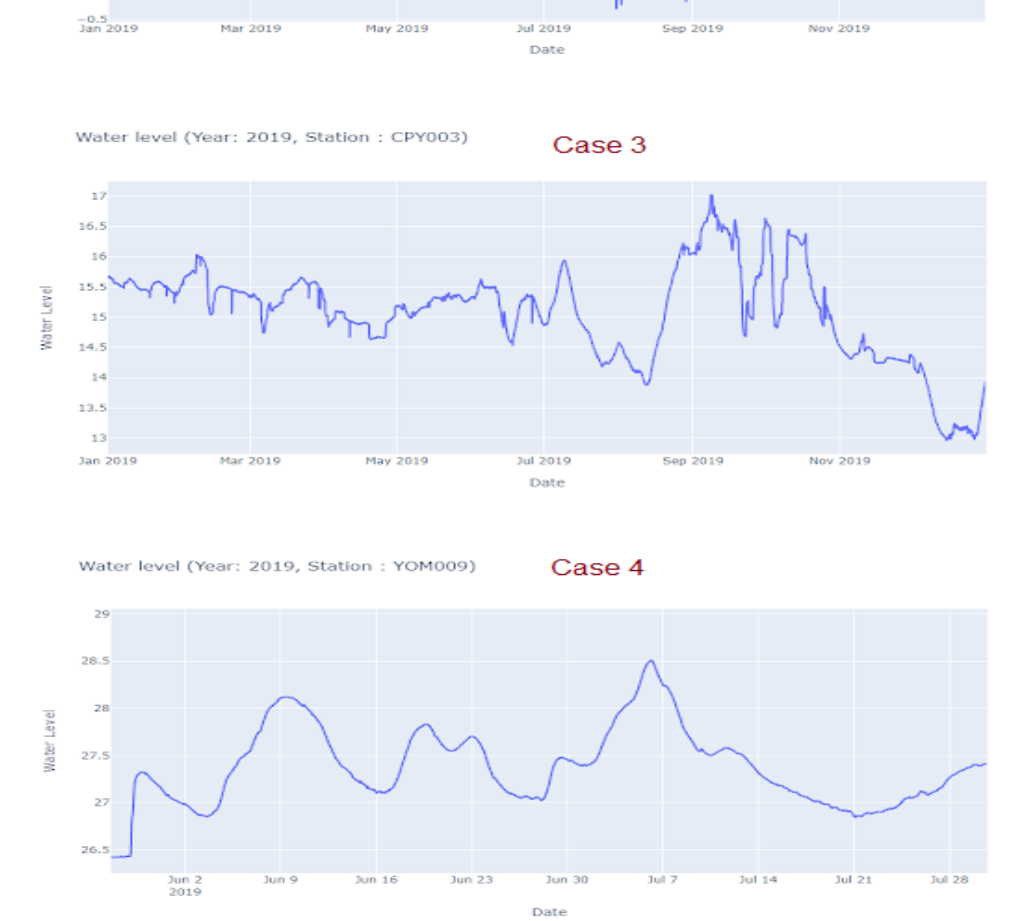
Figure 3. Examples of seasonal behaviors observed from the water level data within each